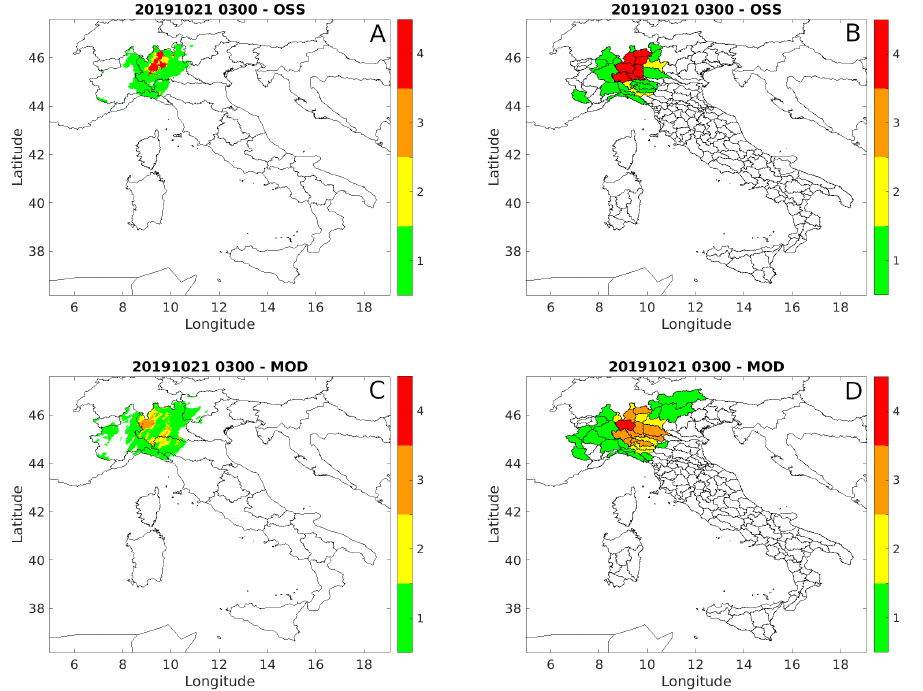
Figure 12. Scenario generated for the 21 October 2019 event at 03 UTC for the next 6 h. Panels ( A , B ) refer to observed scenario, panels ( C , D ) to the modeled one.